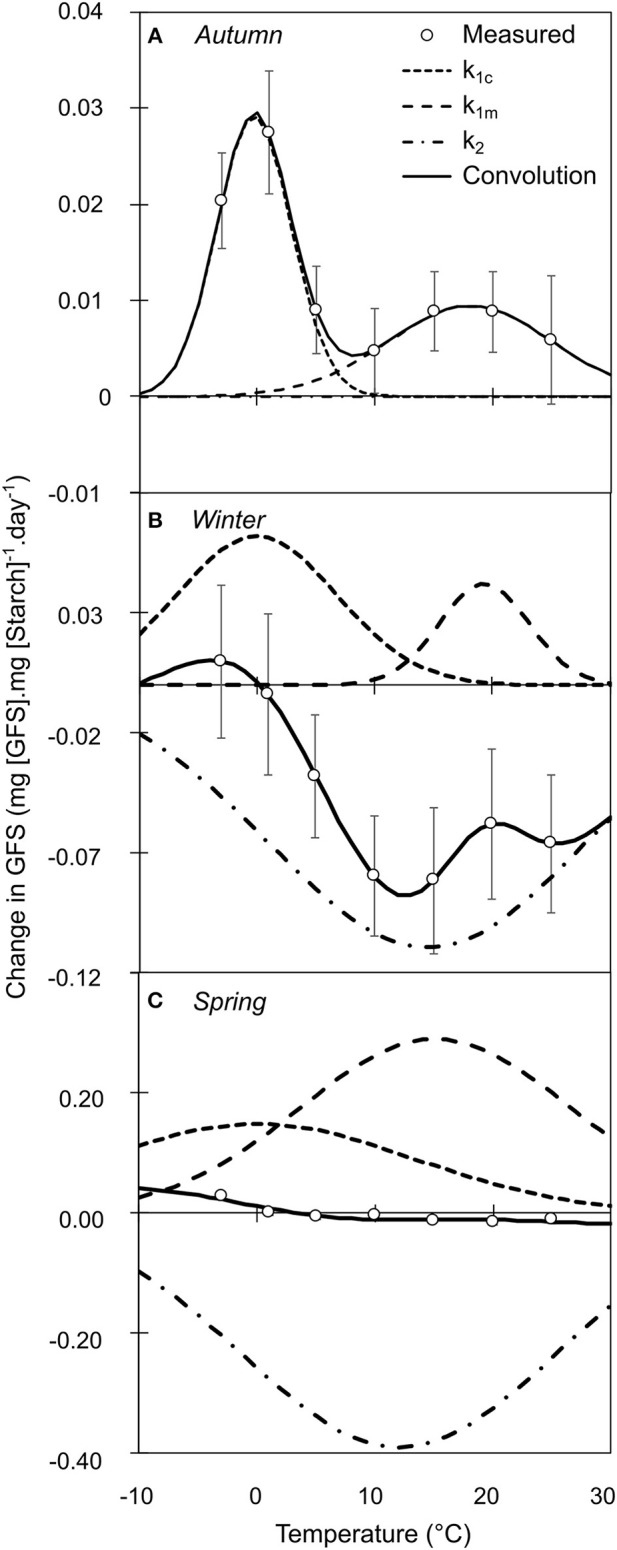
Relative variation in GFS normalized by initial Starch content after constant temperature treatment during autumn (A), winter (B), and spring (C). Each point represents the mean and standard error of n = 26 replicates, across the 2 years of experiment. The black line represents the convolution of three distinct sigmoid functions (k1c: short dash; k1w: long dash and k2: dash-and-dot). The elementary sigmoid functions were relatively constant for optimal temperature, although their maximal value varied over winter.